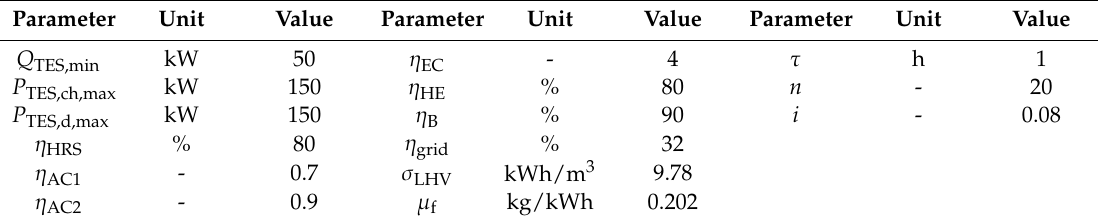
Table 2. Main parameters of the combined cooling, heating and power (CCHP) system.